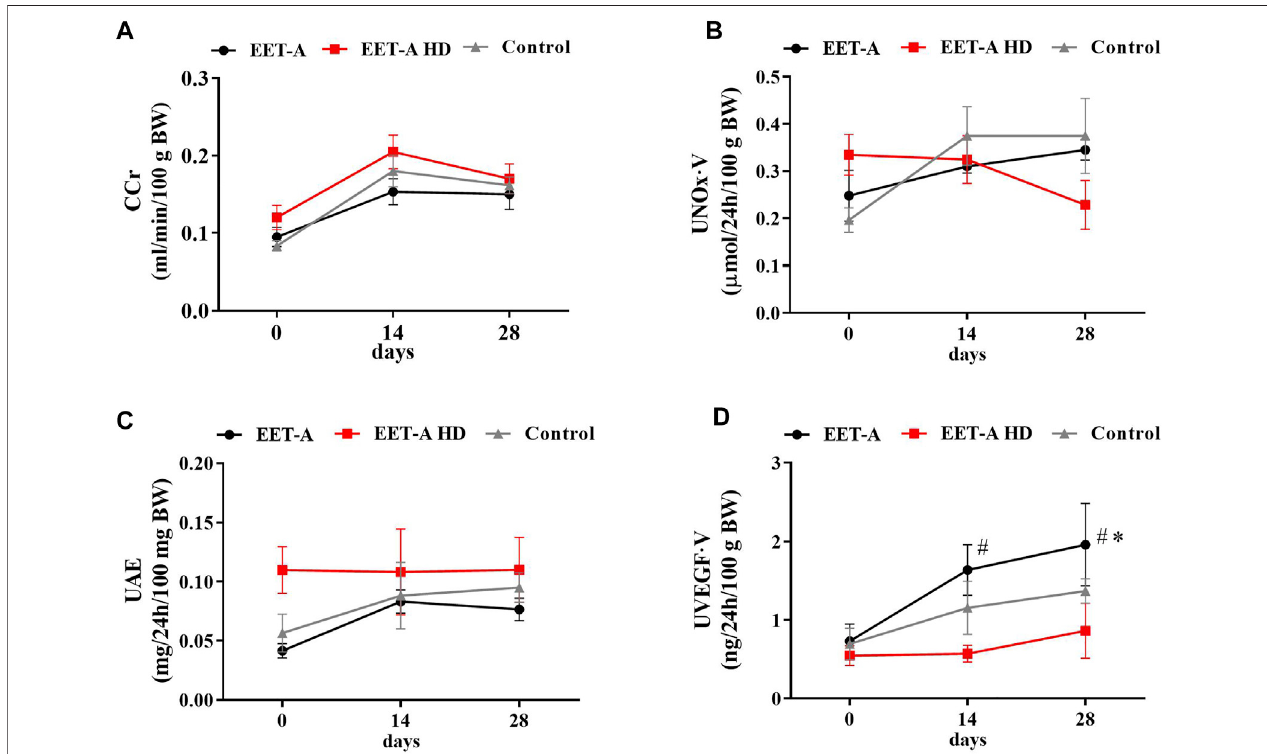
FIGURE2|(A) Creatinineclearance, (B) nitricoxidemetabolitesexcretion, (C) urinaryexcretionofalbumin,and (D) urinaryexcretionofvascularendothelialgrowth factor type A measured on days 0, 14, and 28 in adult spontaneously hypertensive rats receiving epoxyeicosatrienoic acid analog in two doses at 10 mg/kg/day ( n (cid:1) 6, EET-A) and40 mg/kg/day(EET-AHD, n (cid:1) 6);thecontrolgroupreceivedwater( n (cid:1) 6).Valuesareexpressedasmeans ± SEM.* p < 0.05 vs .baselinevalues(day0)within the EET-A group by two-way analysis of variance, followed by Bonferroni ’ s multiple-comparisons test; # p < 0.05 EET-A vs . EET-A HD at the same time point by two-way analysis of variance, followed by Tukey ’ s post-hoc test.